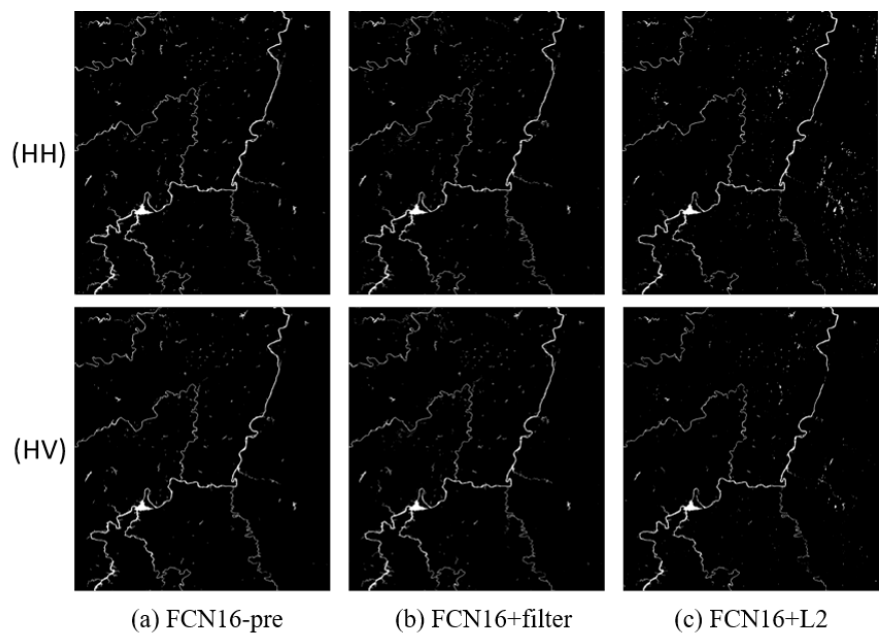
Figure 12. The results of FCN16 in three different conditions of Scene 1: ( a ) FCN16 without pre-process;